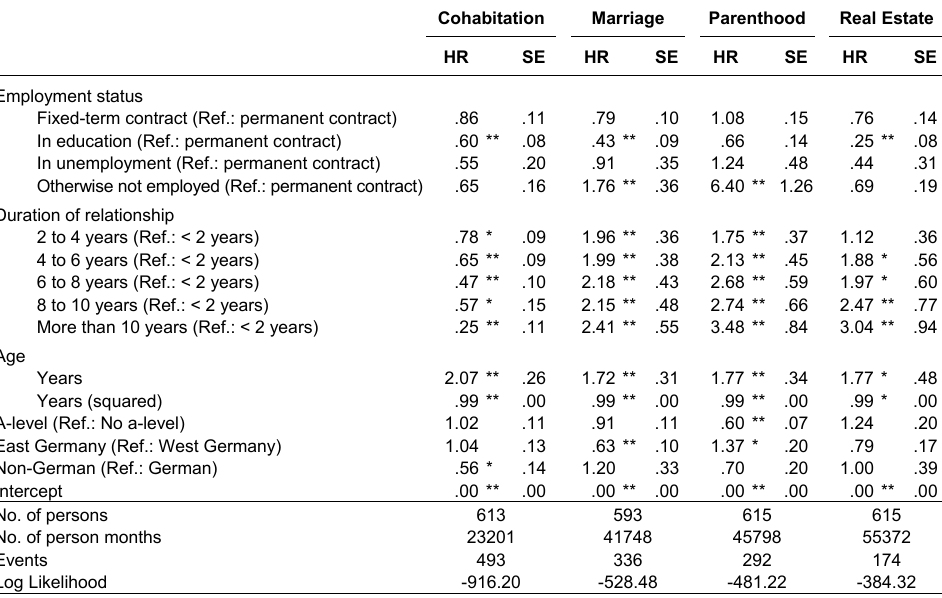
Table 3 : Effects of fixed-term employment on partnership events for women (piecewise-constant exponential models, hazard ratios and standard